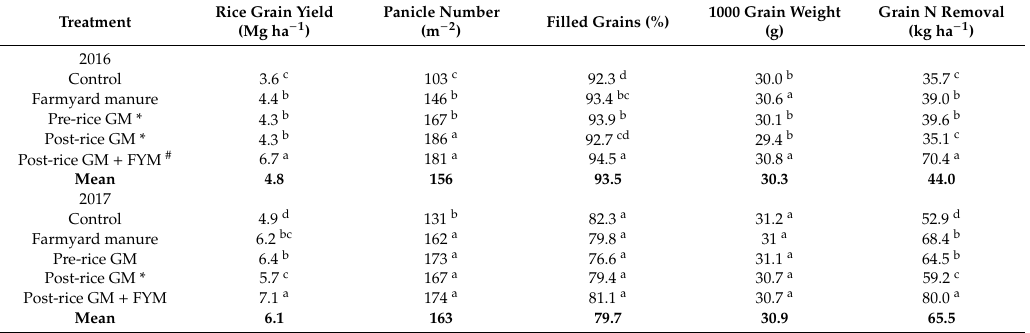
Table 3. E ff ect of organic amendments on grain yield, N uptake and yield components of rainfed lowland rice in Kilombero floodplain, Tanzania in 2016 and 2017 (means across two positions). Treatment